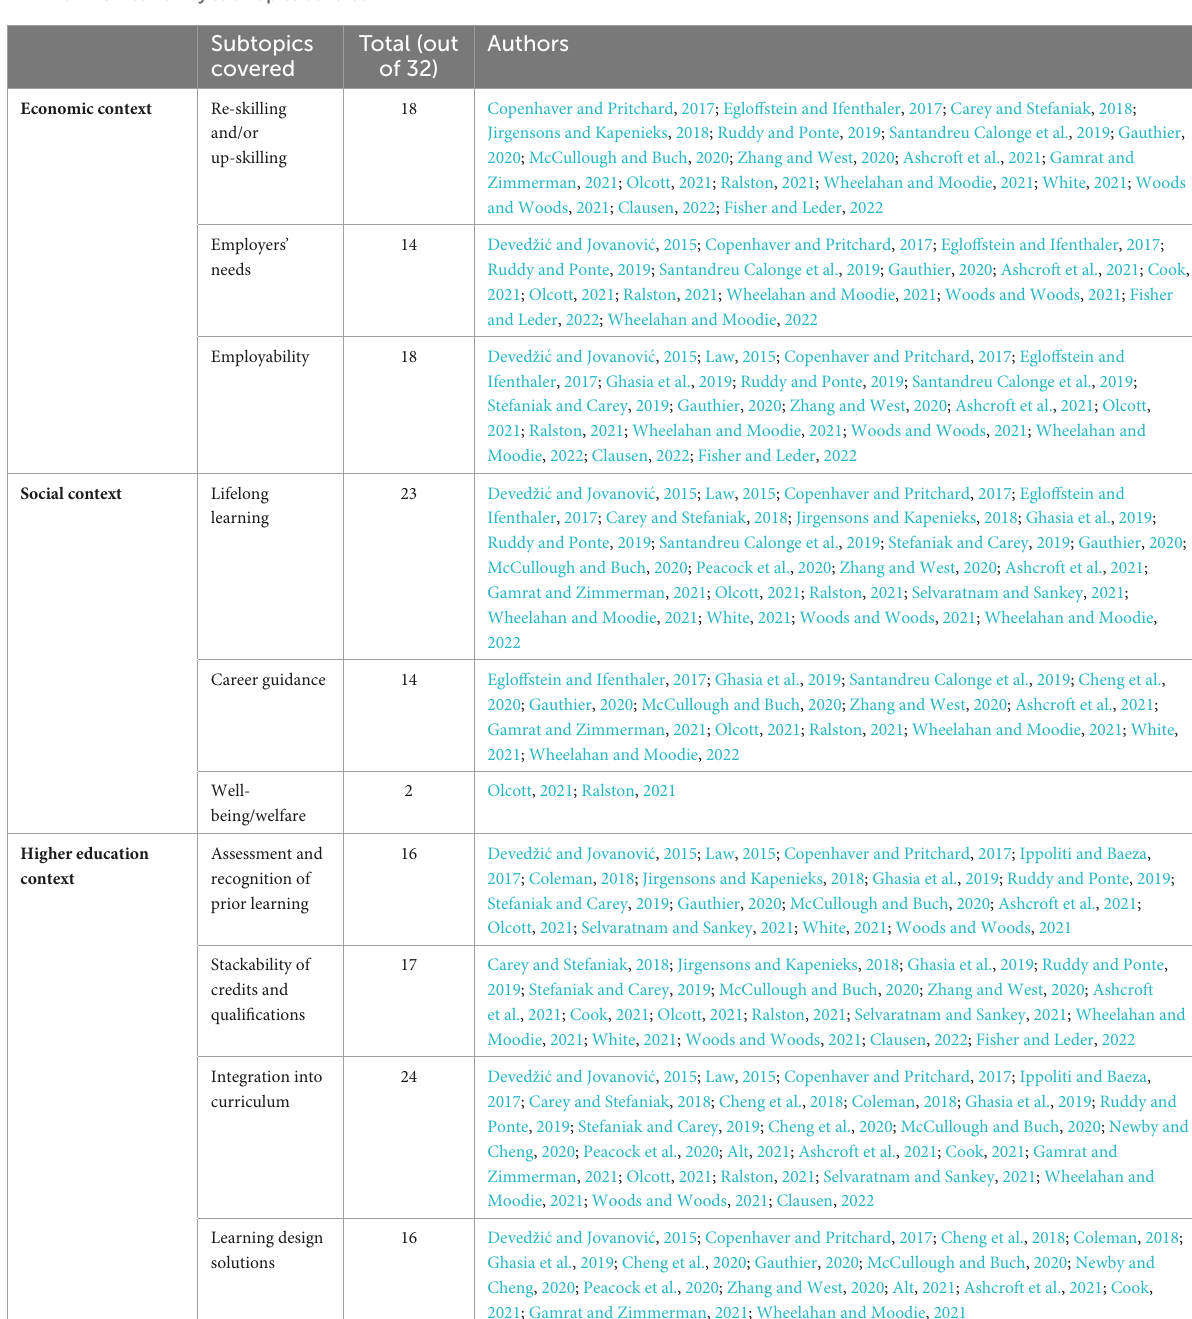
TABLE 5 Distribution by sub-topics